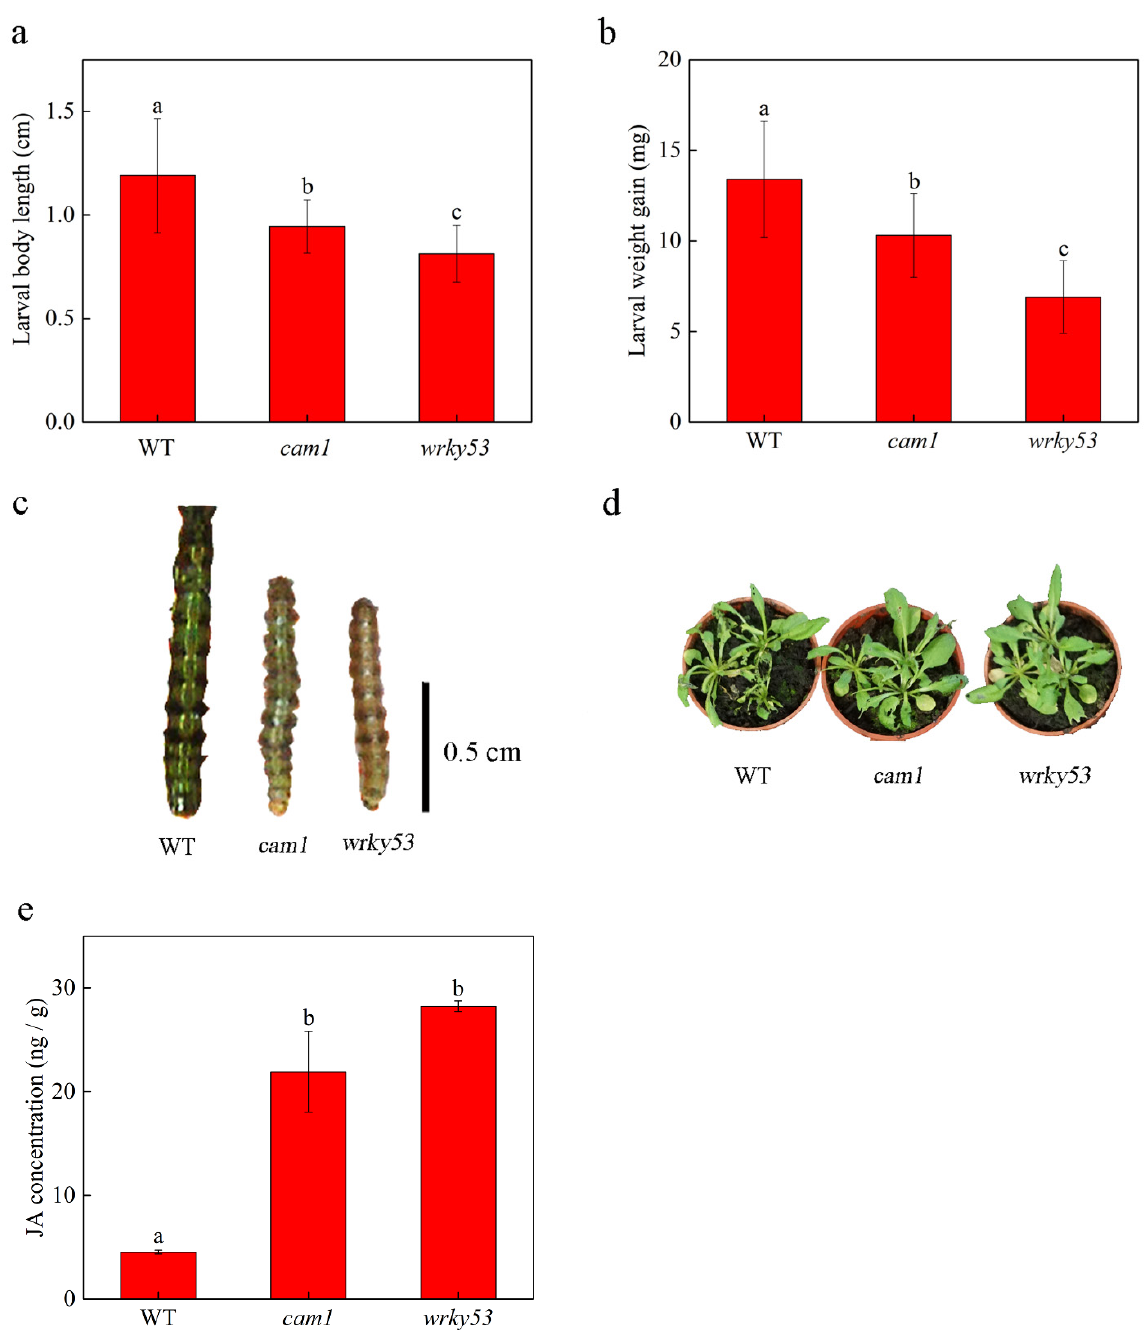
Figure 1. Arabidopsis plants show plant defense against Spodoptera littoralis in cam1 and wrky53 mutants. ( a , b ) Larval body length and weight gain were measured 7 days after inoculation. Every pot had three Arabidopsis plants, one larva was put in each plant and each group contained approximately 25–40 larvae. ( c ) Larvae phenotypes of the WT, cam1 and wrky53 mutants. ( d ) Conditions of plants after 7 days of larval feeding. ( e ) The JA concentration in each group, each group had three biological replicates and every replicate had more than 30 plants. In ( a – d ), plants were grown for 4 weeks (ten leaves), and in ( e ), plants were grown for 2 weeks. Error bars denote ± SEM, columns labeled with different letters are significantly different at p < 0.05, Dunnett’s C (variance not neat).